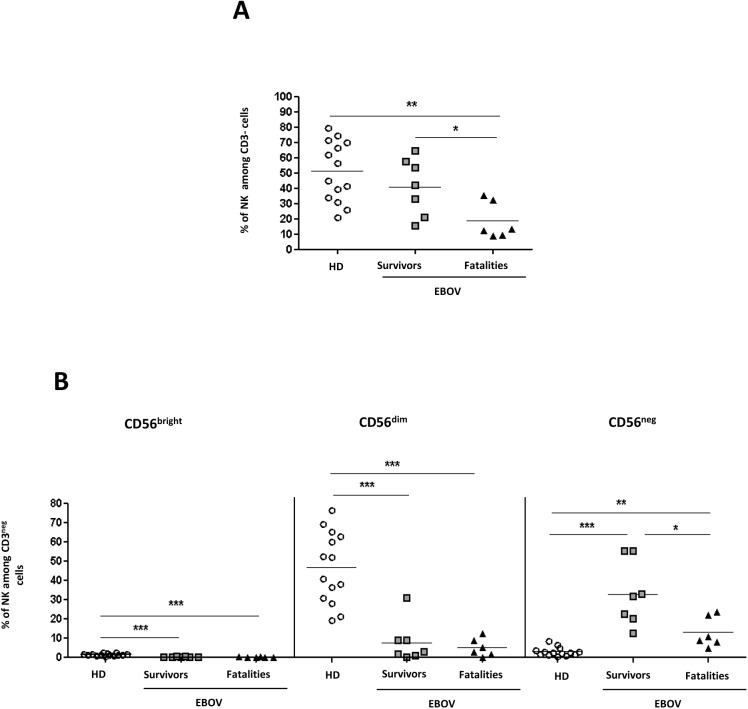
NK cells in survivors and in fatalities.The frequency of NK (A), and of NK subsets (B: CD56bright, CD56dim, and CD56neg) was analyzed in HD (n = 14), EBOV-survivors (n = 7) and EBOV-fatalities (n = 6). Statistical analysis was performed by using Mann Whitney test and differences were considered significant with a p<0.05, and highlighted with an asterisk. *: p<0.05; **: p<0.01; ***: p<0.001.